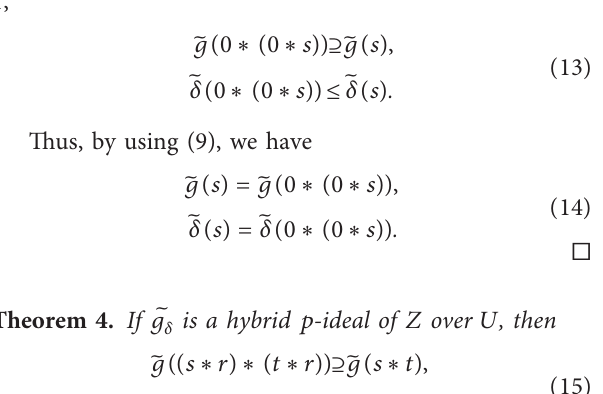
Table 1: Cayley table of the binary operation ∗ . ∗